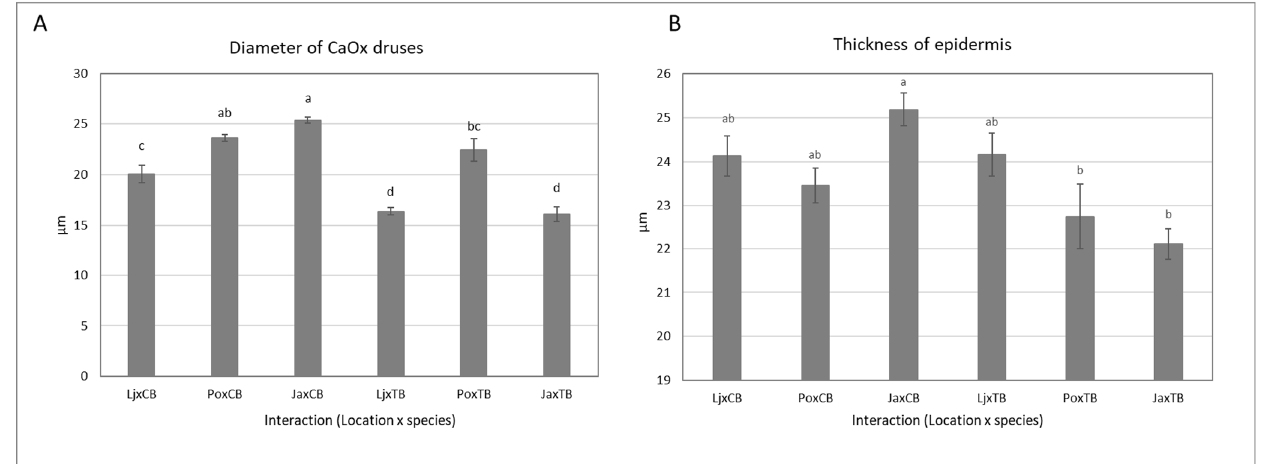
Figure 2. The effect of growth location on concentration diameter of CaOx druses ( A ) and leaf epidermis thickness ( B ) of CB and TB. Data are represented as means ± standard deviation. Means followed by different letters are significantly different at p < 0.05 (n = 8).